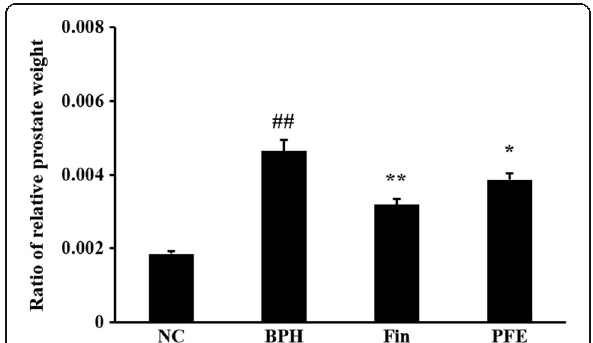
Fig. 3 Effect of PFE on prostate weight in rats with TP-induced BPH. Ratio of relative prostate weight is the ratio of prostate weight to body weight (g/g). NC (normal control group), corn oil injection (s.c.) + PBS administration (p.o.); BPH (control group), TP (3 mg/kg)/corn oil injection (s.c.) + PBS administration (p.o.); Fin (positive control group), TP (3 mg/kg)/corn oil injection (s.c.) + finasteride administration (10